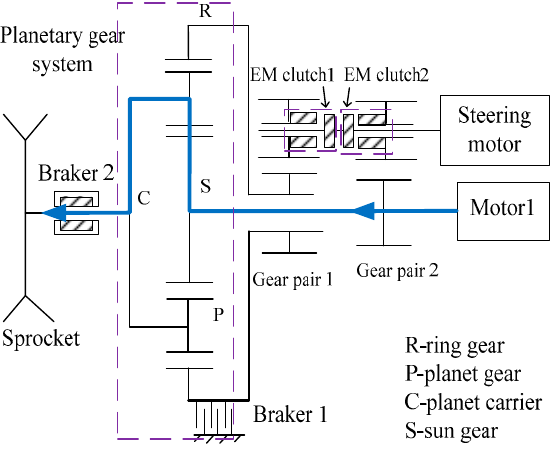
Figure 3. Components of the planetary gear coupler.